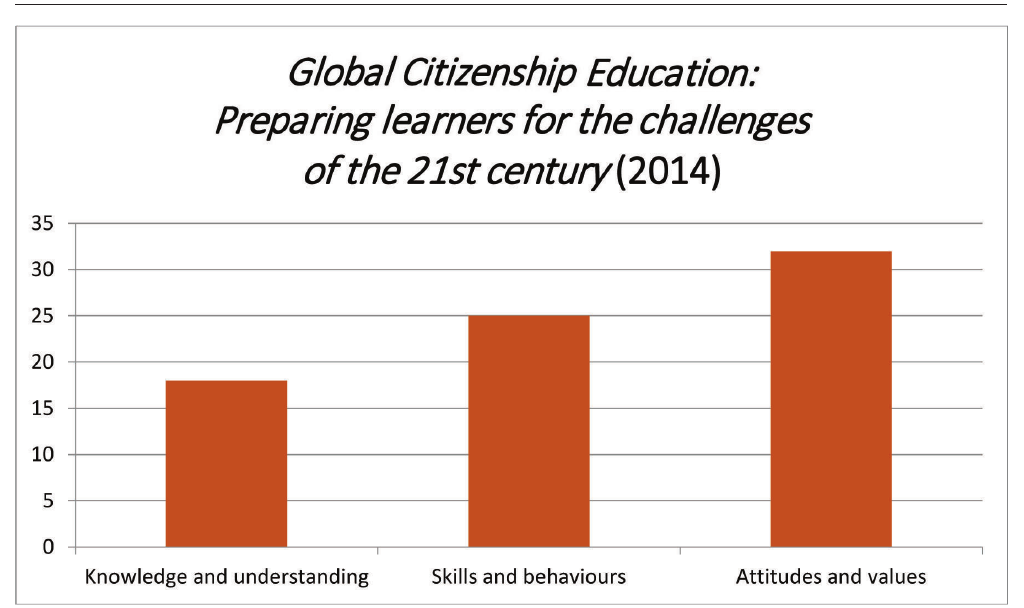
Figure 3: UNESCO (2014) Cluster 1